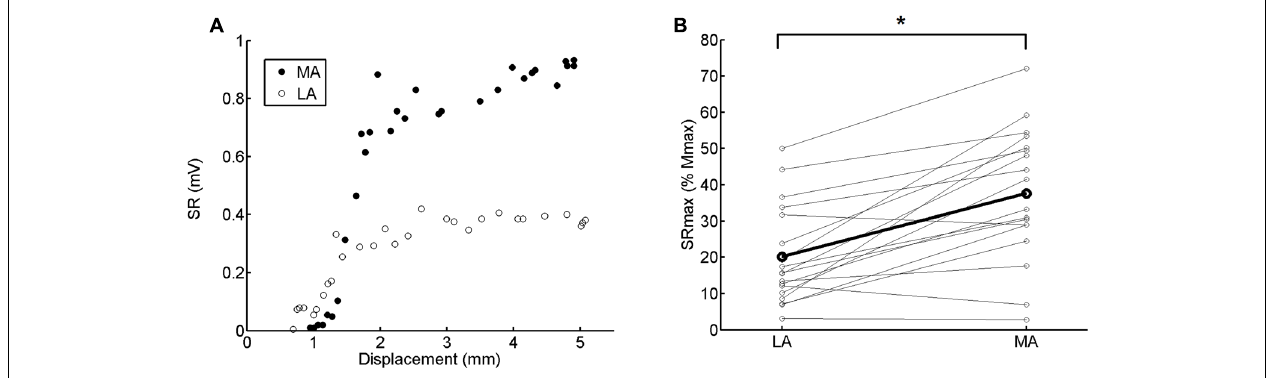
FIGURE 1 | (A) Stretch reflex (SR) recruitment curve obtained in both legs from one representative subject (#3).The displacement of the shaker tip is displayed in the abscissa.The SR max was calculated from the average of the 3 highest amplitude values. Higher absolute values are clearly observed for